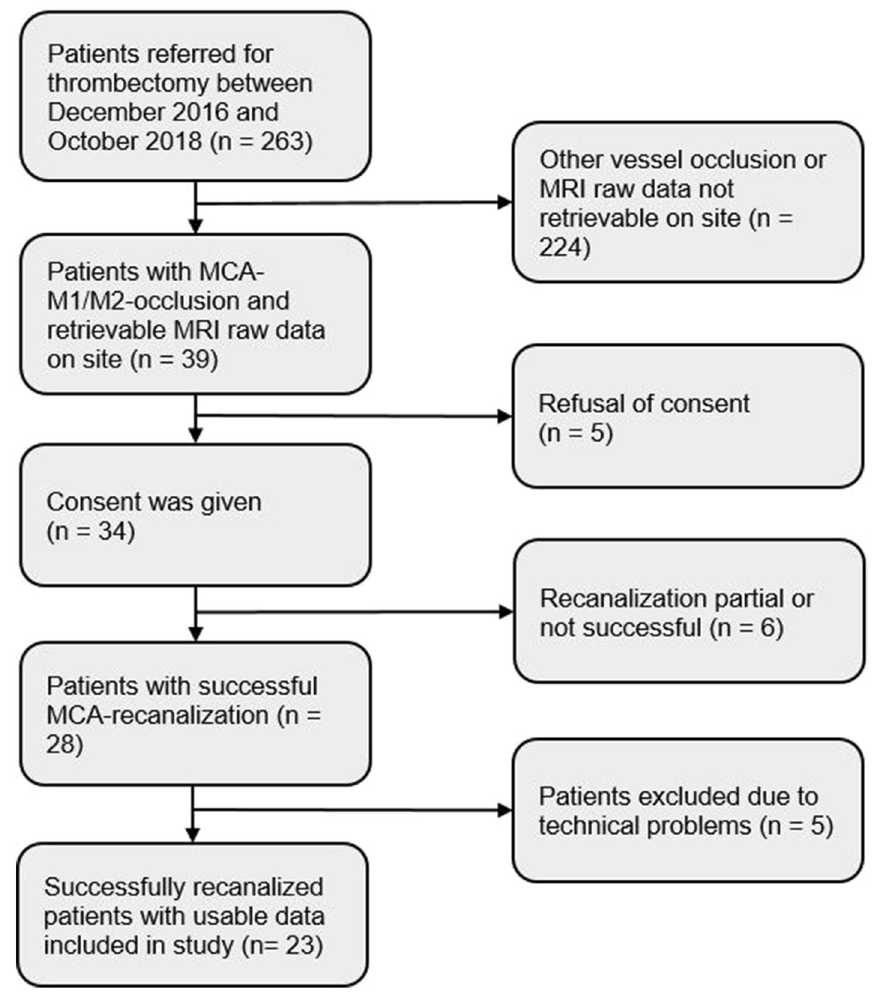
Figure 1. Patient inclusion criteria flow chart. Out of 263 patients referred for thrombectomy between December 2016 and October 2018 in 39 cases with MCA-M1/M2 occlusion MRI raw data for QSM analysis could be retrieved on site and assessed for eligibility. Patients were excluded due to refusal of consent, unsuccessful recanalization or due to technical problems that occurred during image analysis/processing (e.g. blurred images, massive hemorrhages or missing MRI-sequences essential to analysis) leading to 23 patients with successfully recanalized MCA-M1/M2 occlusion included in the current MR image analysis. In all patients, the same six slices representative for the MCA territory were selected. MCA territories were anatomically defined as areas supplied by the middle cerebral artery. Massive hemor- rhages compromising cortical vein detection (applicable to three patients) were identified and excluded from the analysis considering standard imaging approaches for hemorrhages (SWI and CT scans were checked for each patient). Images were then analyzed using the Image J (NIH) software 34 . For each individual, a threshold was applied such that pixel above this threshold were considered to be veins without marking any background tissue. Thresholds were kept constant during analysis of each individual. Susceptibility values from QSM images within semi-automatically drawn masks of individual cortical veins that appeared prominent were analyzed, regardless of their site. An example is demonstrated in Fig. 2 showing the DWI, SWI and QSM as well as cortical veins on 3 representative slices of the MCA territory. When cortical veins were not identifiable semi-automatically because of interference with background tissue, a manual selection was added. In that case, we inspected the suscepti- bility maps and their maximum intensity projections (MIP) across 6 mm as well as the SWI image to identify cortical veins precisely. In addition, all semi-automatically drawn maps were visually compared to susceptibility maps, susceptibility weighted images and their MIPs to correct for contributions of uncompletely removed back- ground fields originating from the sinus cavities and background tissue, which is shown in Fig. 3. Vein masks were drawn by two independent experts. Both examiners then agreed on what should be included into the vein mask. The interrater variability was analyzed utilizing Interclass Interrater Coefficient (ICC), which showed values between 0.94 and 0.98, indicating high interrater reliability (please see more detailed information in the supplementary material). Vein susceptibilities were calculated from the 10% highest signal within the vein mask to minimize partial volume effects; and values from both examiners were averaged. A distinction was made